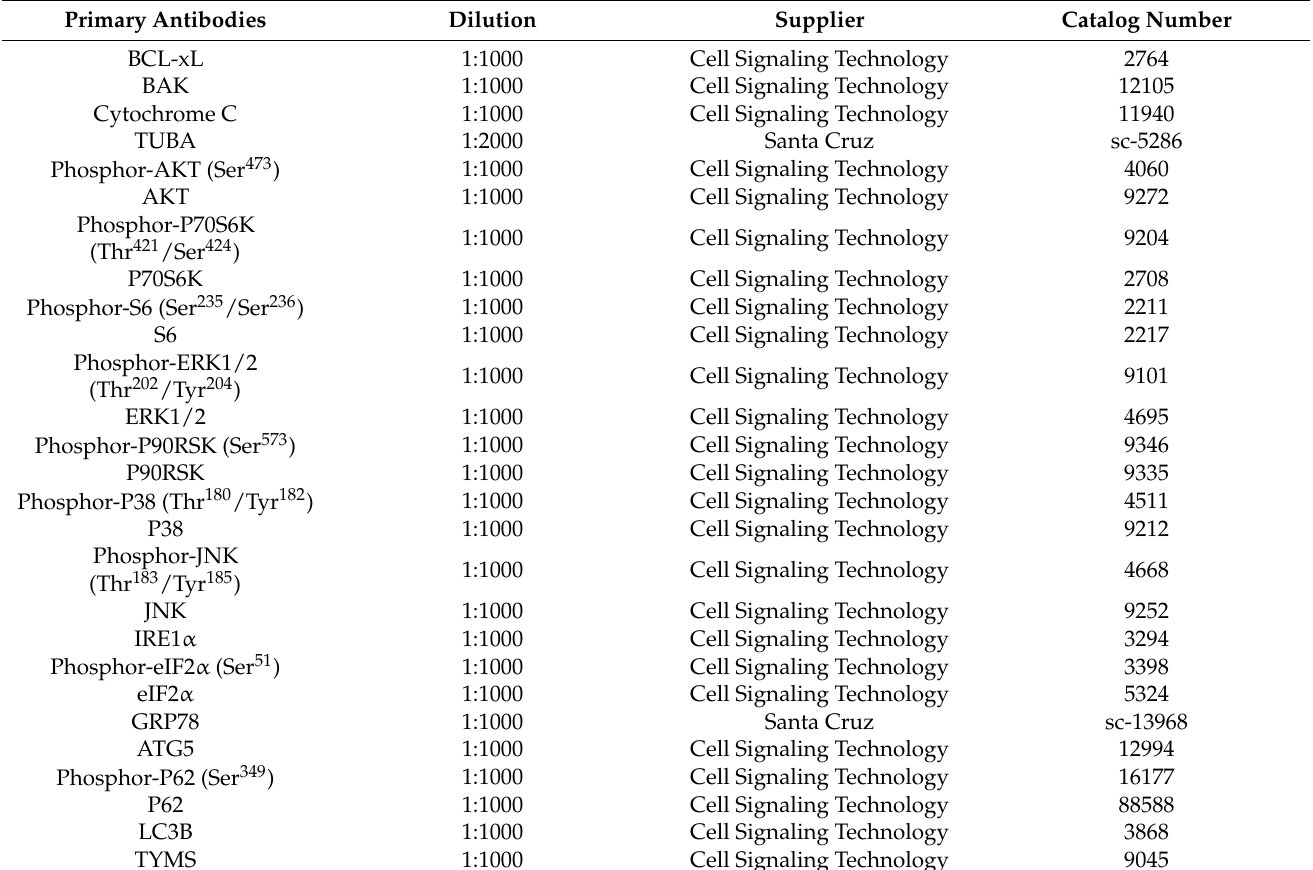
Table 1. Primary antibodies used in Western